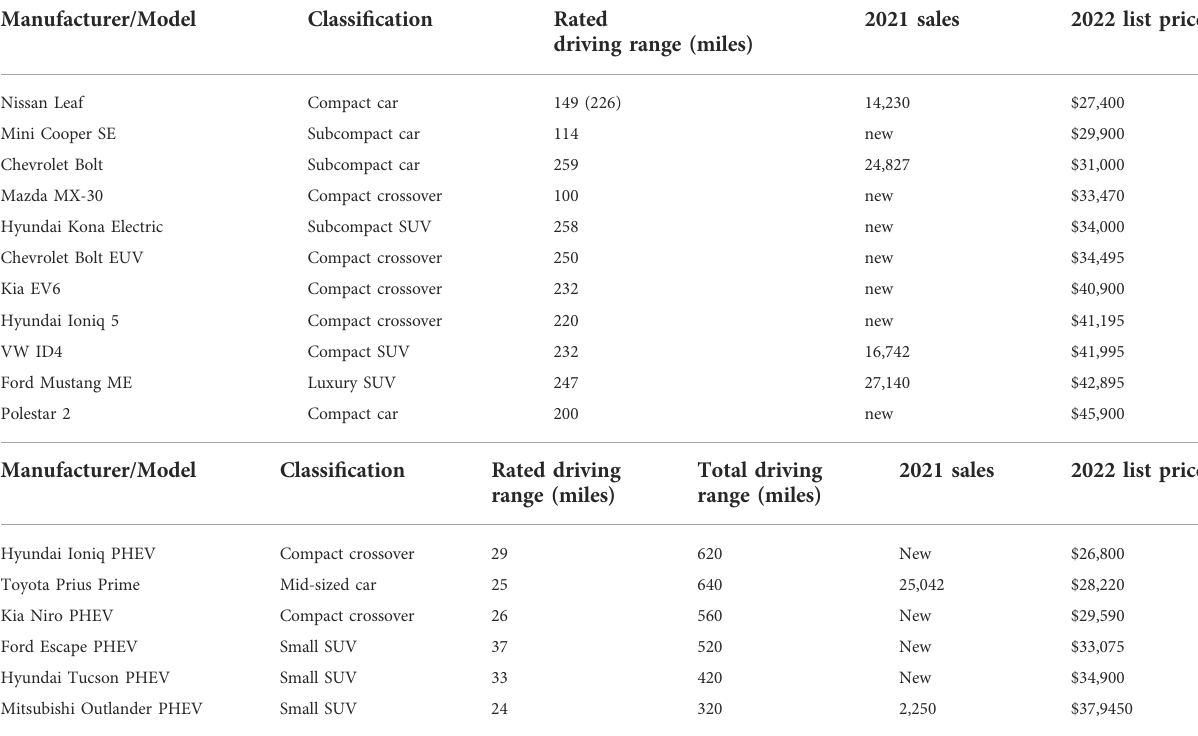
TABLE4AffordableelectricvehiclesontheUSmarketrankedby2022listprice;modelyear2022battery-electricvehiclesandplug-inhybridelectric vehicles (Edmunds.com, 2022).